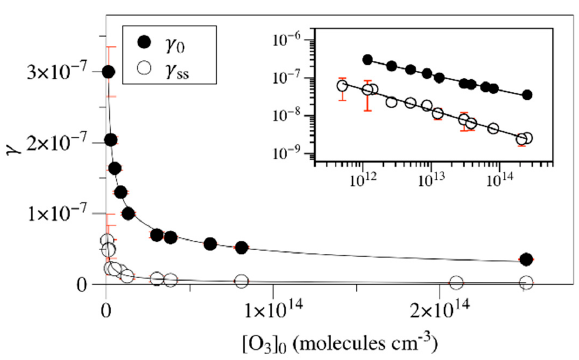
Figure 2. γ 0 and γ ss of ozone on Gobi dust as a function of [O 3 ] 0 . The solid lines are power function fittings of γ and [O 3 ] 0 . The embedded figure corresponds to the logarithmic display mode. Experiments were carried out at room temperature and atmospheric pressure using a fixed bed reactor. Error bars were determined from the overall experimental dispersion.